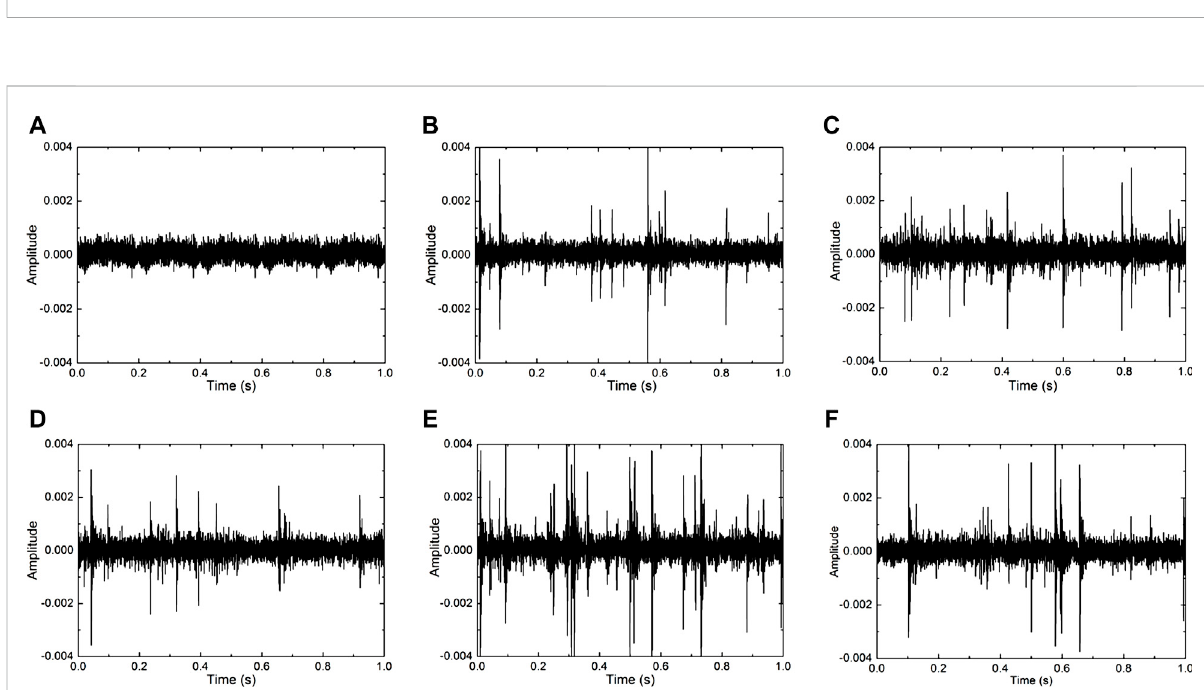
turbine. The bolt attaching the hub and the blade was loosened to simulate this condition. 6) Blade pitch angle twist (pitch angle twist): To produce power from wind energy, the turbine shaft is linked to the wind